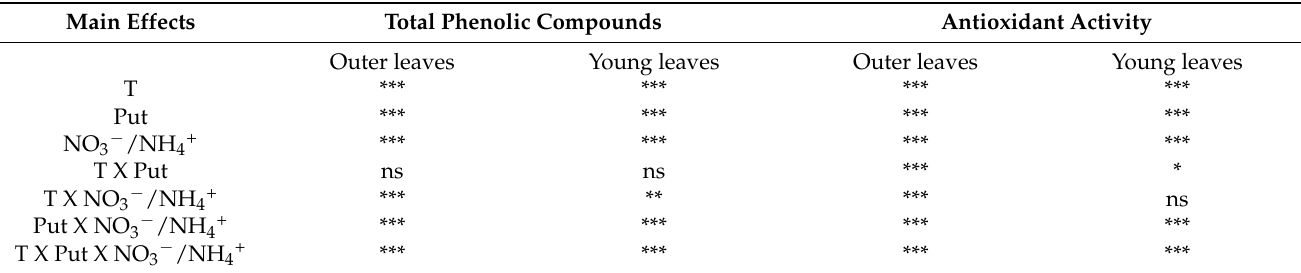
Table 1. Explanation statistical of the data exhibited in Figure